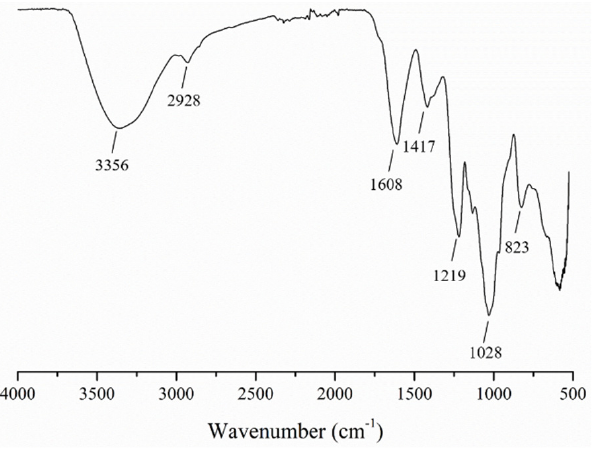
Figure 1. FT-IR spectrum of the SFP.